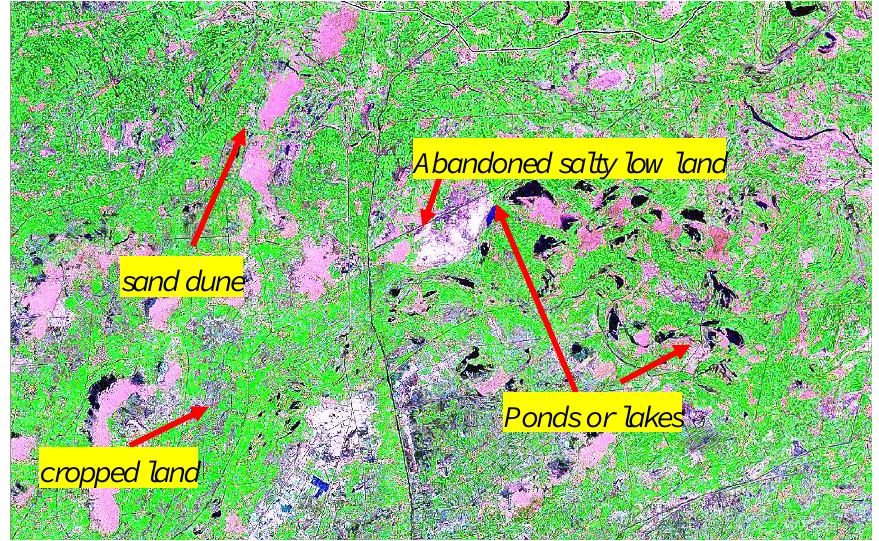
Figure 9. General land cover in HID (snapshot of LANDSAT image P129 r31 on August 9, 2001 at a scale of